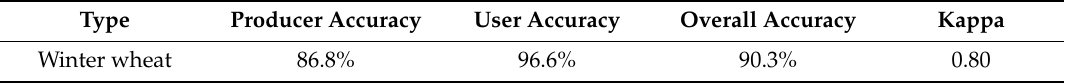
Table A1. The classification accuracy for winter wheat in NCP in 2019.